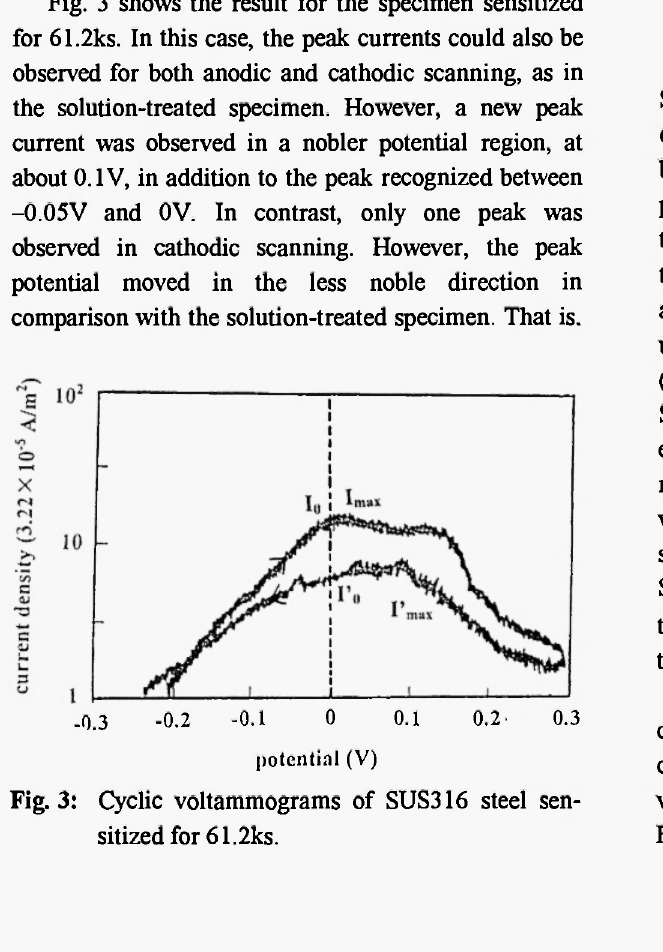
4: Cyclic voltammograms of SUS316 steel